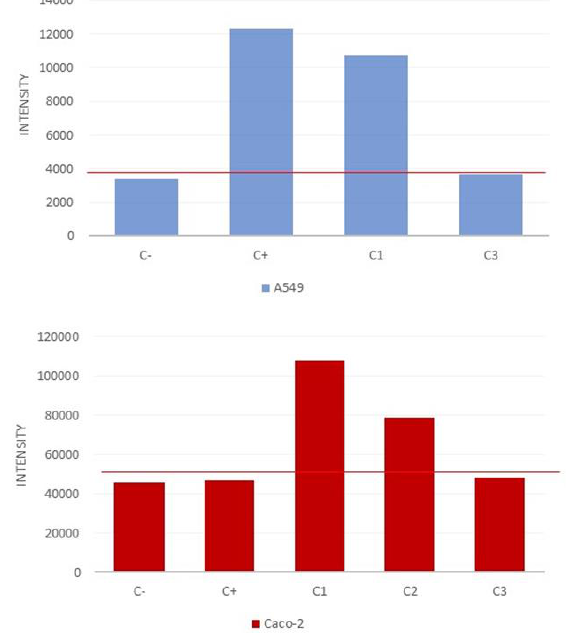
Figure 15. ROS generation in the cell lines A549 ( top ) and Caco-2 ( bottom )after an exposure period of 24 h. Concentrations: C1, 20 ppm; C2, 10 ppm; C3, 5 ppm.